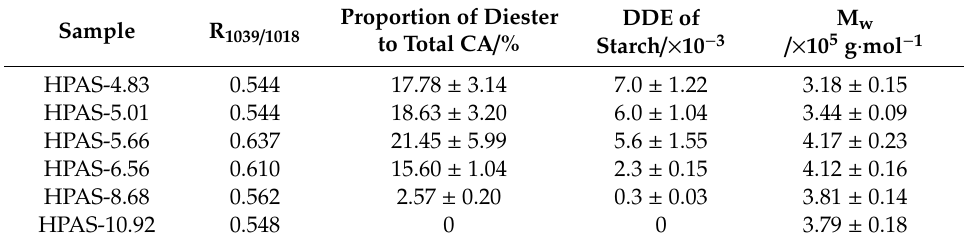
Table 2. Diesterification (DDE), R 1039 / 1018 , and M w of the HPAS-CA films. Proportion of Sample R 1039 / 1018